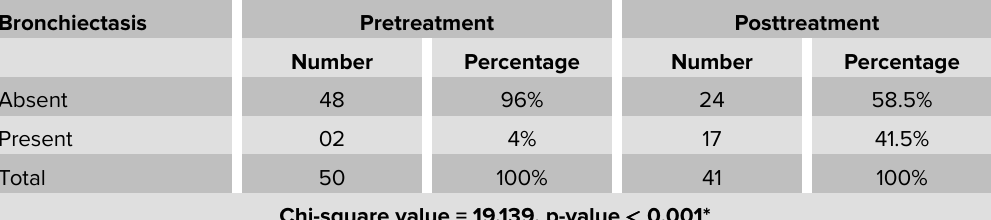
TABLE 7: Frequency distribution of bronchiectasis in pre- and posttreatment